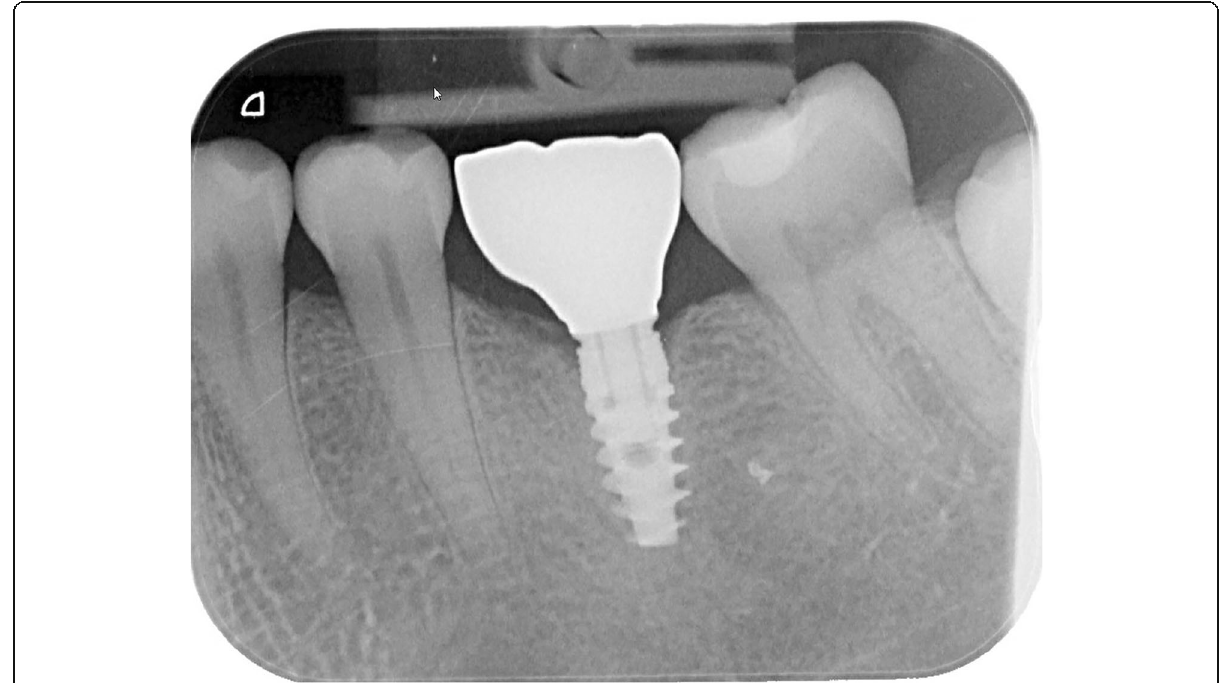
Fig. 2 Intraoral radiograph of an immediately placed post-extractive dental implant with a full contour zirconia restoration after 1 year (same patient as in Fig.